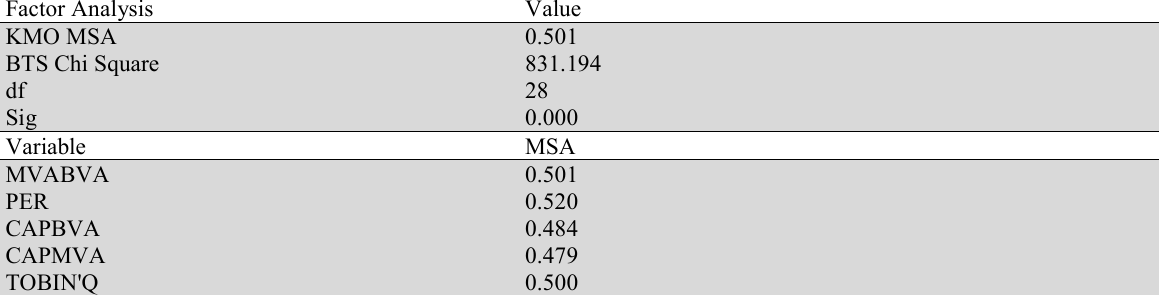
Communalities (Extraction Method Principal Component Analysis)